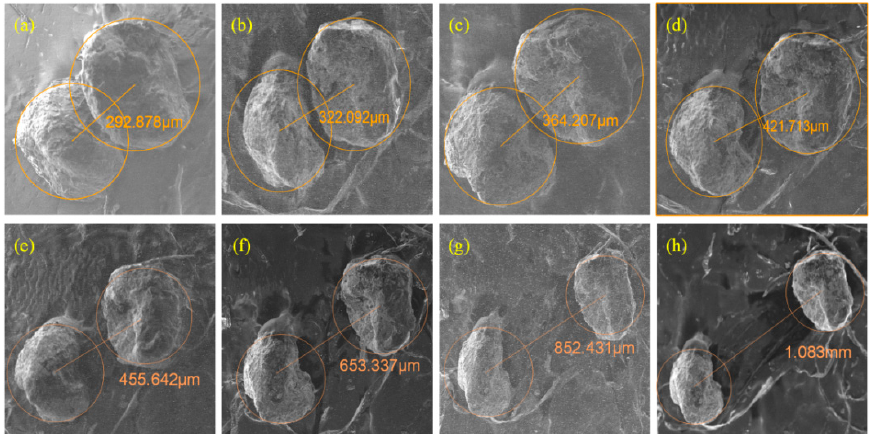
Figure 15. The dual particle system at different distances. ( a ) l p = 292.878 µ m (overlapping wear particles); ( b ) l p = 322.092 µ m; ( c ) l p = 364.207 µ m; ( d ) l p = 421.713 µ m; ( e ) l p = 455.642 µ m; ( f ) l p = 653.337 µ m; ( g ) l p = 852.431 µ m; ( h ) l p = 1.083 mm.